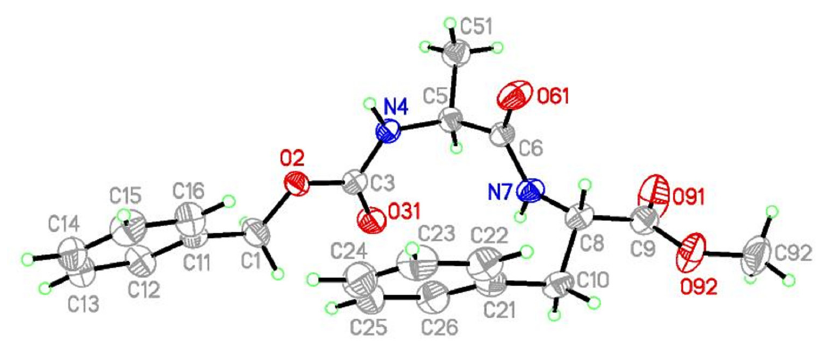
Figure 1. Perspective view of Z-AF-OMe with displacement ellipsoids at the 50% probability level.